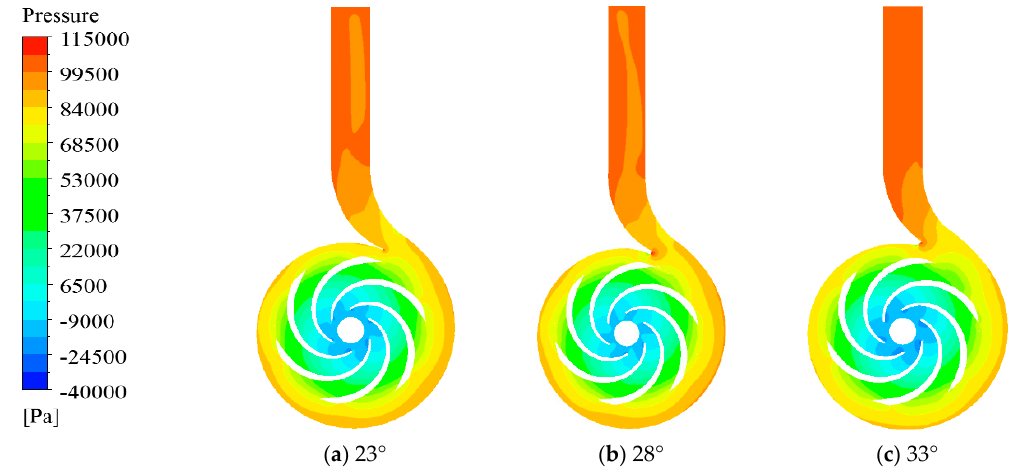
Figure 14. Velocity distribution on volute cross section under design flow rate condition with different volutes.